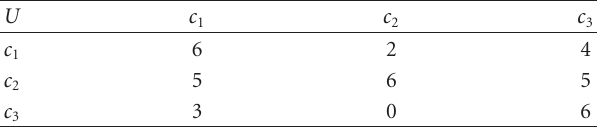
Table 8: Comparison table for false-membership